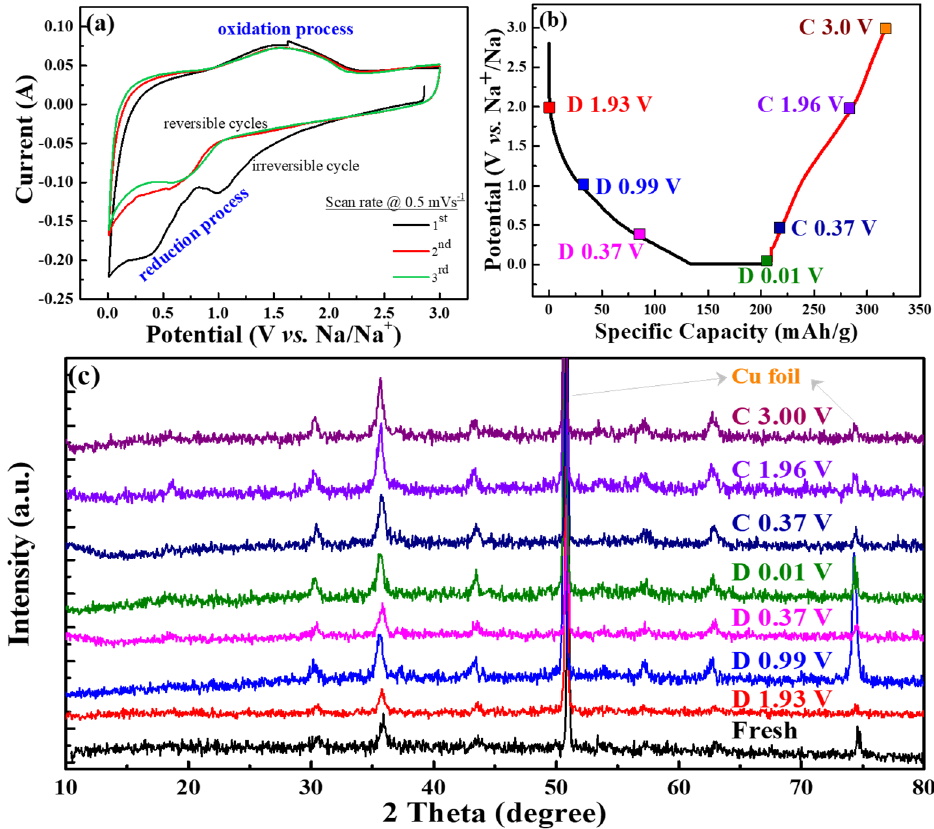
Figure 7. Sodiation / desodiation mechanism analysis of the CoV 2 O 4 material electrode cell: ( a ) cyclic voltammetry (CV) curves in the potential window range of 0.01–3.0 V at a scan rate of 0.5 mV s − 1 ; ( b ) discharge / charge profile at various voltage states for ex situ studies; and ( c ) ex situ XRD analysis.